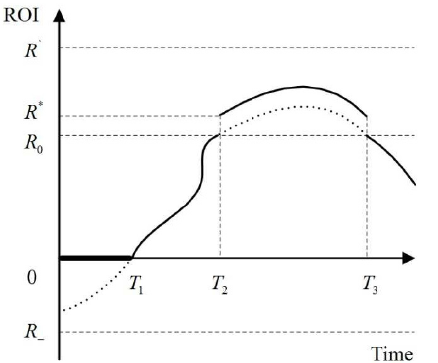
Fig. 2. Motivation-embedded ROI